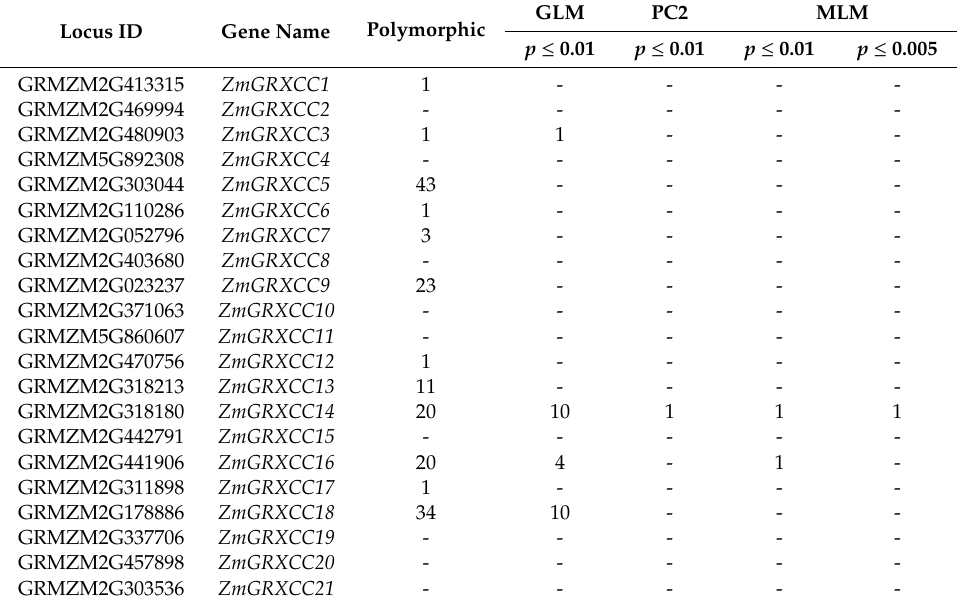
Table 2. Association analysis of natural variation in ZmGRXCC genes with respect to drought tolerance at the seedling stage in the maize diversity panel. GLM, PC2, and MLM stand for general linear model, general linear model with the first two principal components, and mixed linear model,